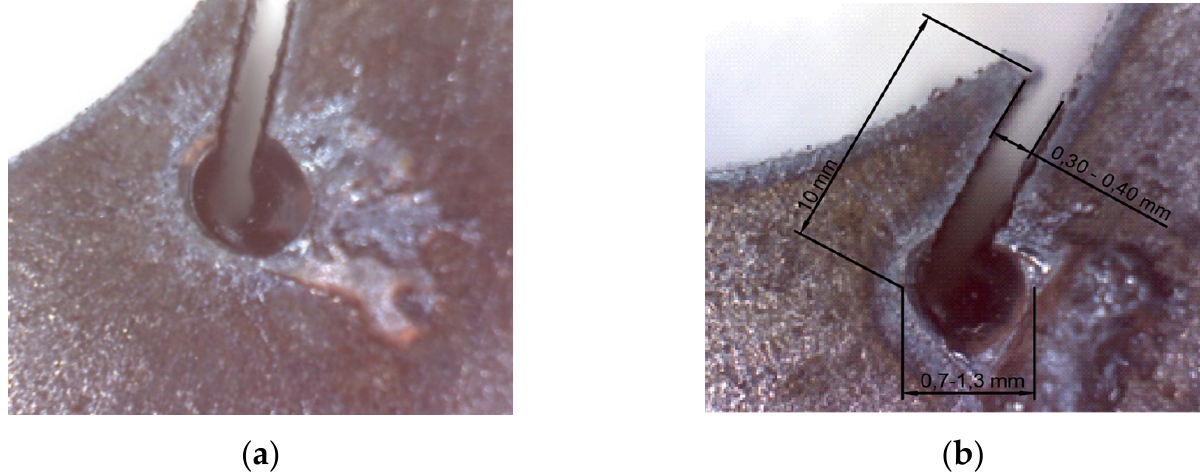
Figure 3. ( a ) Part 1 with the pierced channel; ( b ) Part 28 with the perforated